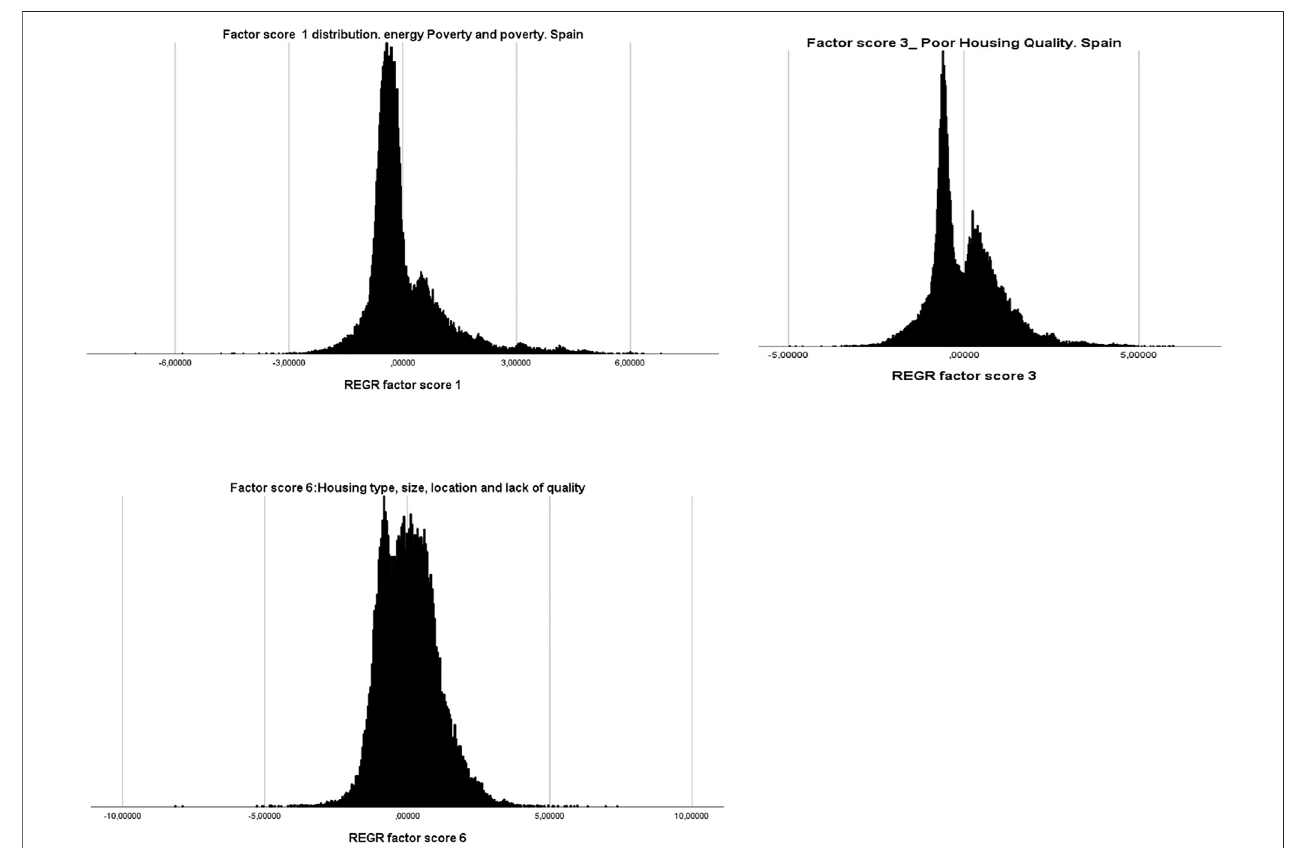
FIGURE 2 | Distribution of energy poverty factors scores.